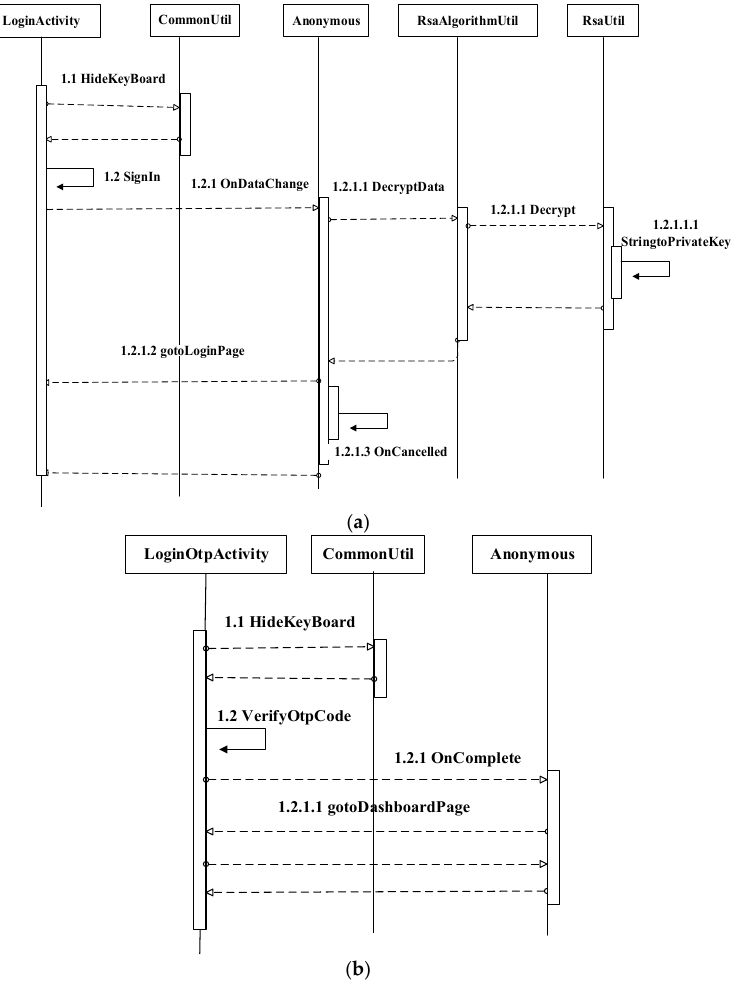
Figure 7. ( a ): Login activity of proposed method and ( b) : Login OTP activity of proposed method. In ( a ), Step 1.1: The LoginActivity will hide the keyboard in the CommonUtil and return to the LoginActivity . Step 1.2: The signing starts and ends with LoginActivity and waits for the response. Step 1.2.1: Then, loginactivity sends a request onDataChange to anonymous. Step 1.2.1.1: Then, anon-